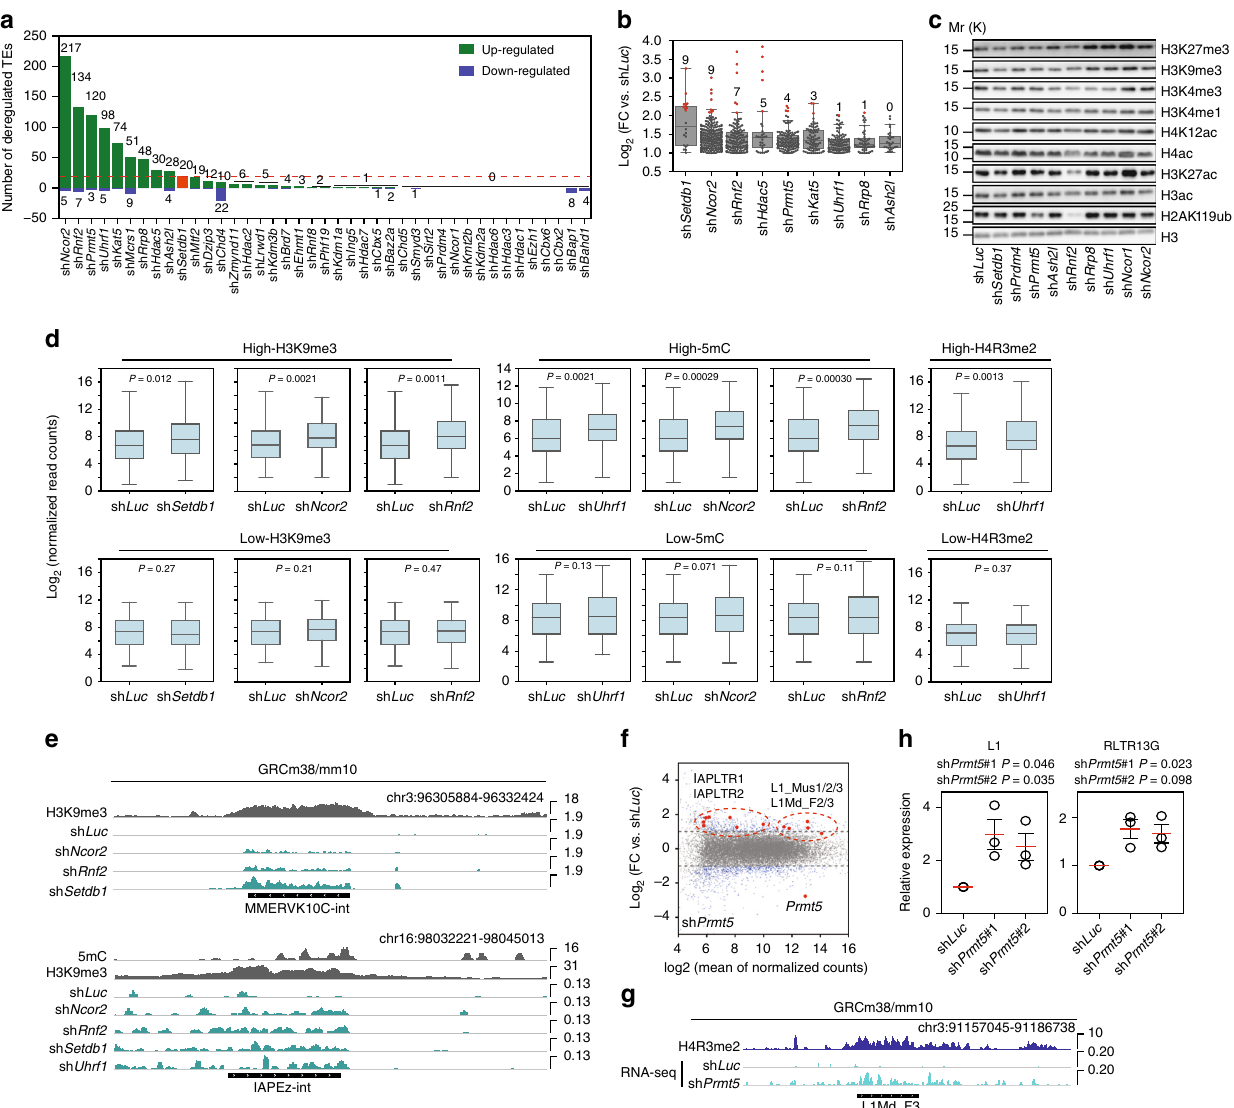
Fig. 3 Chromatin modi fi ers regulate the type-speci fi c expression of TEs. a Number of signi fi cantly deregulated TE types for the indicated shRNA knockdown ( P values < 0.05, Benjamini & Hochberg corrected, absolute fold-change >2, relative to sh Luc ). See Supplementary Data 1 for detailed sample information. b Boxplots of log2 (fold-change (FC) versus sh Luc ) for all signi fi cantly deregulated TE types. In the boxplot, outliers represent the mean of a TE type. TE types signi fi cantly upregulated > 4 fold are indicated in red and the number is marked. c Western blot of chromatin marks, from the indicated shRNA knockdowns. Molecular weight is indicated as Mr (K). This experiment was performed twice with similar results. d Boxplots of the expression level for all TE types with either High or Low levels of the indicated chromatin mark. High was de fi ned as those TE types with > 2-fold enrichment of the indicated chromatin mark. Low sites were selected by ranking the TEs by fold enrichment, and taking TEs from the bottom of the list until it was the same length as the High list. e Genomic views of MMERVK10C-int and IAPEz-int showing chromatin marks and RNA-seq in the indicated shRNA knockdown. f MA-scatter (log-fold-change, mean average expression) plot showing sh Prmt5 knockdown relative to sh Luc . Blue dots are signi fi cantly different genes or TEs ( P value < 0.05, Benjamini & Hochberg corrected, absolute fold-change> 2, relative to sh Luc ). Red dots indicate IAP or LINE1 elements, or the Prmt5 gene. RNA-seq data was from 2 biological replicates. g Genome view of H4R3me2 ChIP-seq data and sh Prmt5 RNA-seq data for L1Md_F3 LINE1. h RT-qPCR expression of the LINE1 L1Md_F2, and RLTR13G, relative to sh Luc control knockdown. P values are from a one-tailed Student ’ s t -test. The circles are the mean of three technical replicates, the red bar is the mean of the three biological replicates, and the error bars are the standard error of the mean. Source data are provided as a Source Data fi le. Primers used are described in Supplementary Data 7. For the boxplots, the midline indicates the median, boxes indicate the upper and lower quartiles and the whiskers indicate 1.5*interquartile